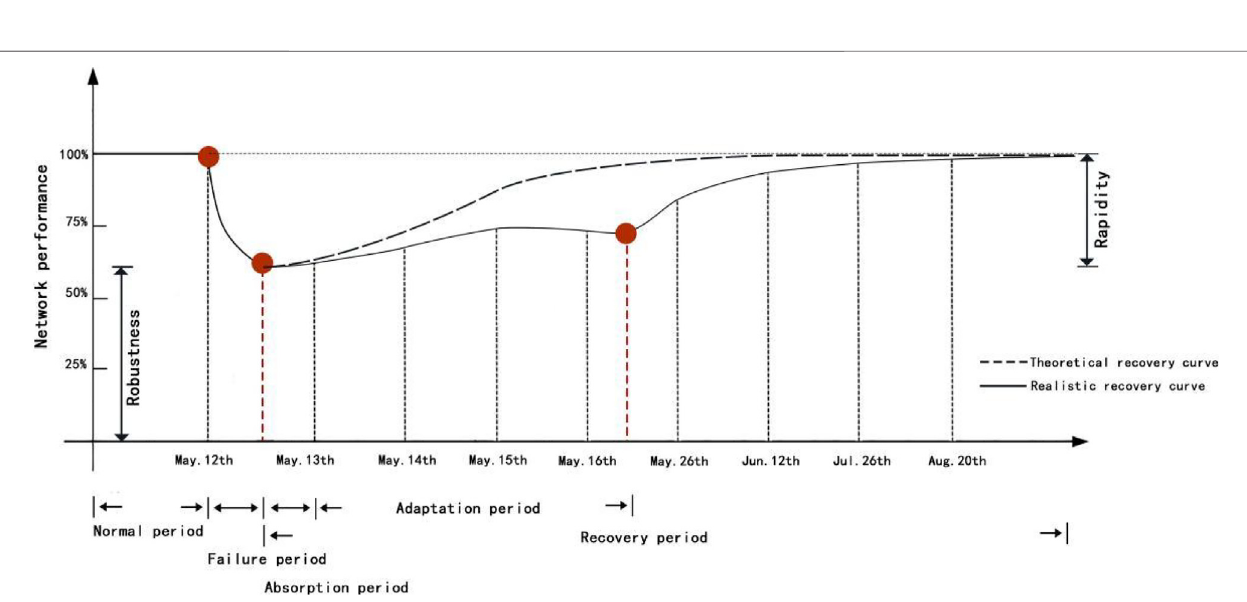
FIGURE 14 | Resilience curve of traf fi c system in mountainous disaster